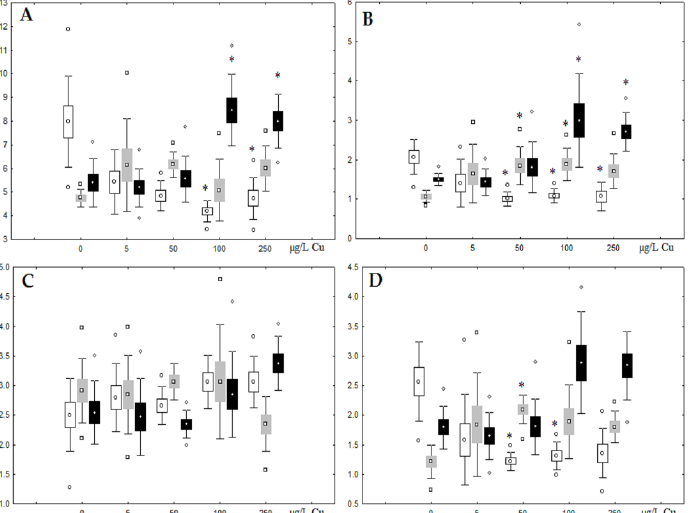
Figure 7. Content (% dry weight) of ( A ) phospholipids, ( B ) triacylglycerols, ( C ) cholesterol, and ( D ) cholesterol esters in the digestive glands of A. cygnea under experimental copper effects: white box – day 1 of the experiment; grey box – day 3 of the experiment; black box – day 7 of the experiment. * – significant results in comparison with control (0 µg/L Cu). Differences were estimated using the nonparametric Kruskal – Wallis test; p < 0.05.